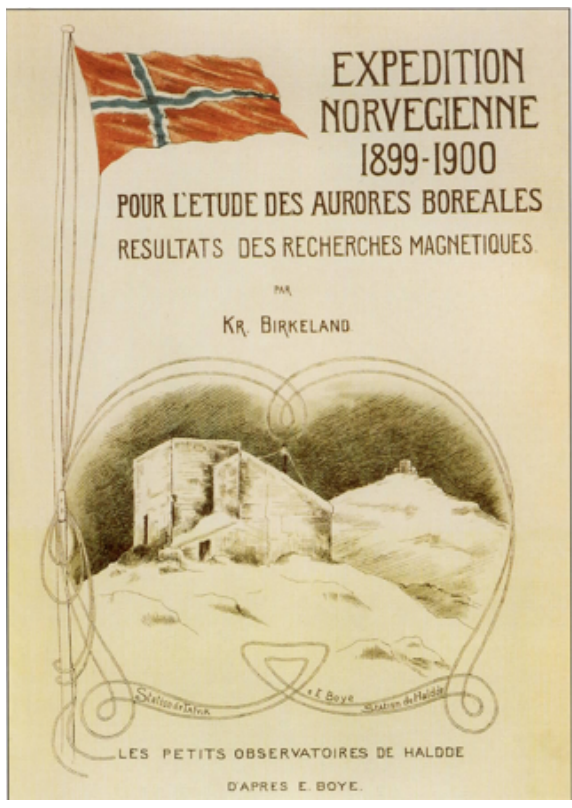
Figure 2. The front page of the report from the expedition to Haldde in 1899–1900 drawn by Elias Boye (Birkeland,